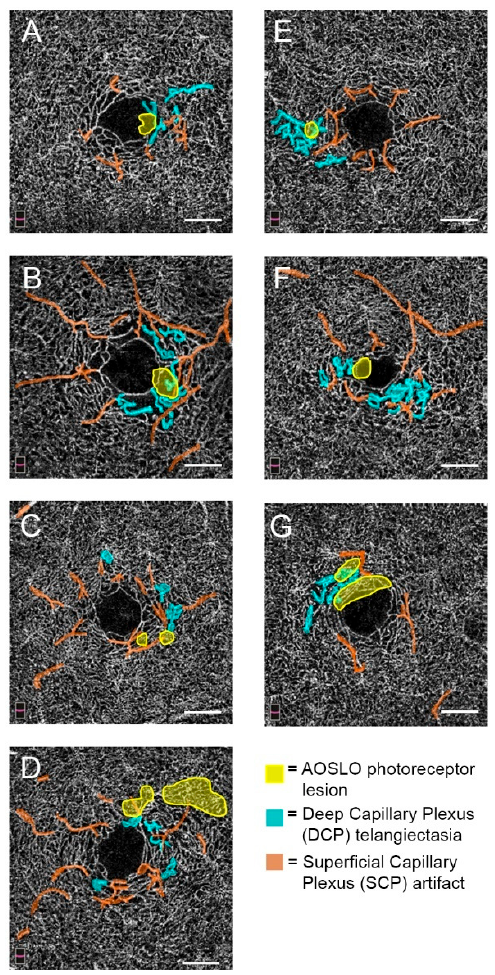
Figure 2. En-face optical coherence tomography angiography (OCTA) images of the deep capillary plexus (DCP) of MacTel eyes reveal areas of telangiectasias, that are in proximity to sites of AOSLO photoreceptor lesions. Subjects 1–7 ( A – G ). In each DCP slab, telangiectasias, shown in blue, are either adjacent to, or overlapping with, areas of photoreceptor lesions, shown in yellow. Superficial capillary plexus (SCP) artifacts are shown in orange. Scale bars = 500 μ m.